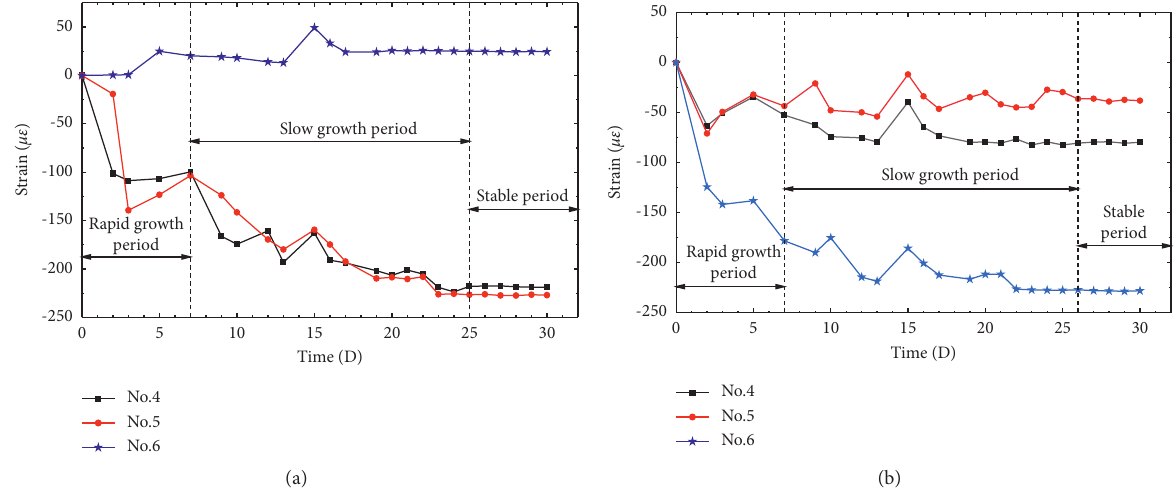
Figure 11: Strain variation of HPC for − 1120m ingate. (a) Circumferential strain of HPC for ingate. (b) Axial strain of HPC for